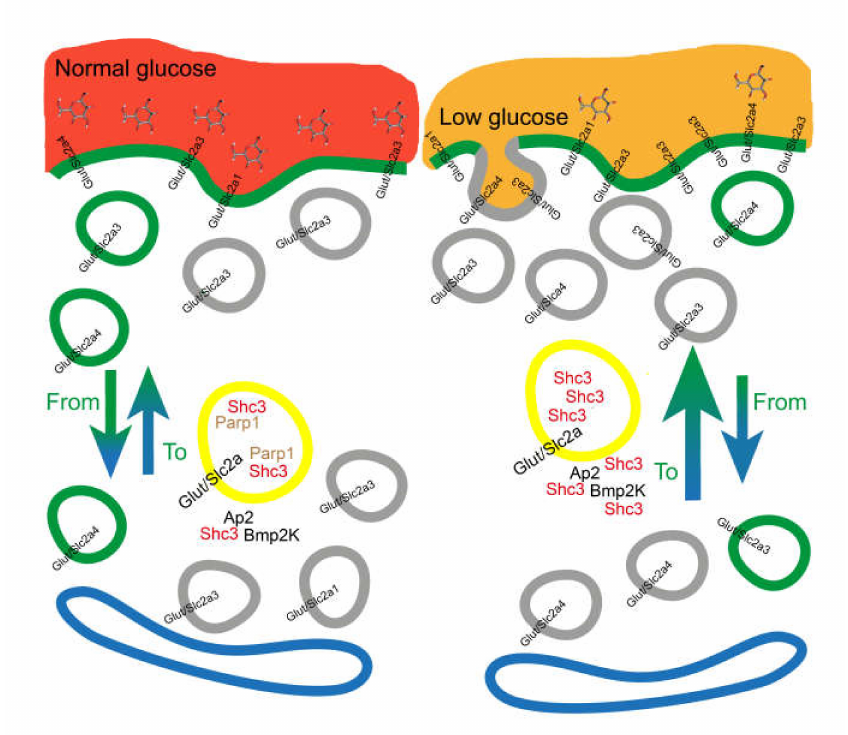
Figure 8. Glioblastoma cells maximize their glucose uptake by modulating glucose transporter tra ffi cking. When glucose is freely available in the medium (normal glucose) tra ffi cking of GLUT / SLCA2 containing vesicles to and from the membrane is balanced, when glucose is limited or absent (low glucose) vesicle tra ffi cking becomes skewed towards the membrane. Some of the protein involved in this tra ffi cking are Shc3, BMP2K, PARP1 and AP2. We found that in low glucose conditions SHC3 increases while vesicle associated PARP1